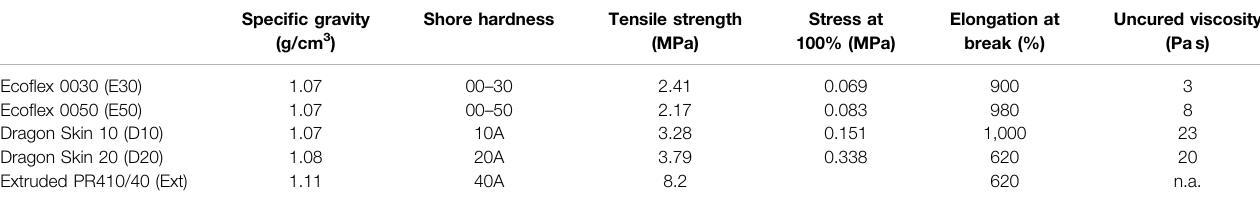
TABLE 1 | Silicones used in this study. The values are extracted from the datasheets 6 . Young ’ smodulus isestimated as the stress at 100% elongation. Eco fl ex and Dragon Skin are used for molding and PR410/40 for extrusion. Speci fi c gravity Shore hardness Tensile strength Stress at (g/cm 3 ) (MPa) 100%